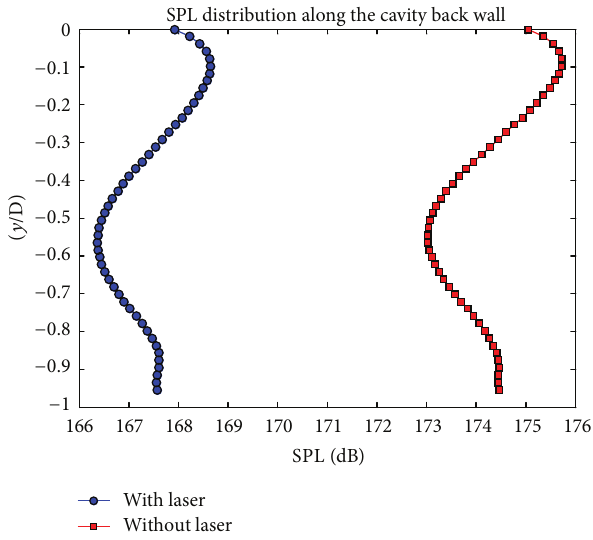
Figure 3: SPL distribution along the cavity back wall.